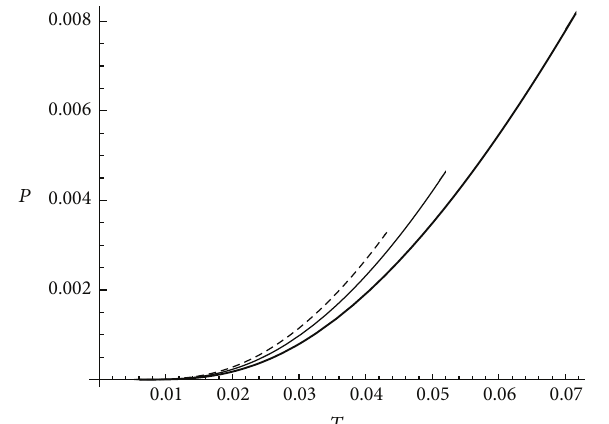
Figure 3: 𝑃 versus 𝑇 when 𝑘 = 1 , 𝑄 = 1 . Dashed curve for ̃𝛼 = 0 , common curve for ̃𝛼 = 0.05 , and thick curve for ̃𝛼 = 0.1 .